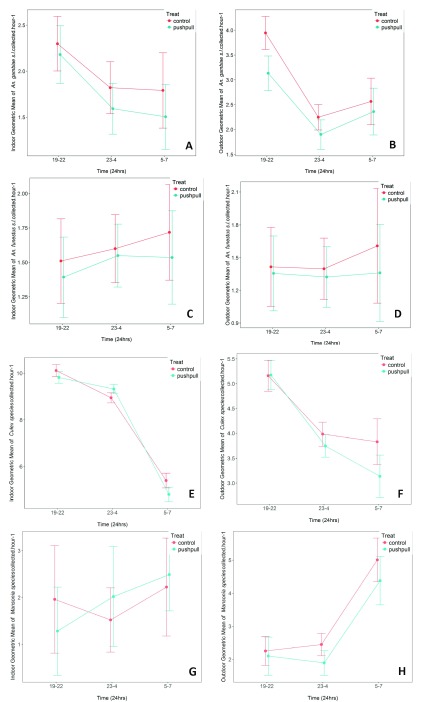
Cumulative geometric mean number of host-seeking malaria vectors caught indoors and outdoors.(
A &
B) represent
Anopheles gambiae; (
C &
D) represent
Anopheles funestus; (
E &
F) represent
Culex species; (
G &
H) represent
Mansonia species. The mosquitoes were caught during early night, midnight and early morning hours. Differences between treated and control huts are shown. Error bars represent 95% Confidence Intervals.